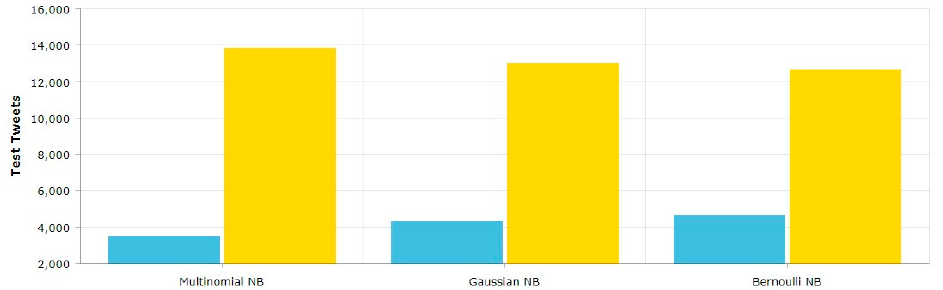
Figure 10. Graphical representation of the number of posts classified correctly/incorrectly for the algorithms Multinomial NB, Gaussian NB, Bernoulli NB.